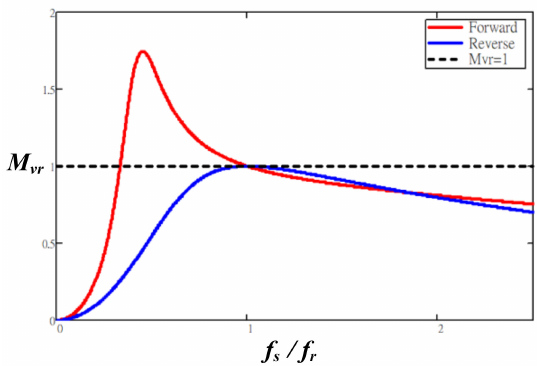
Figure 2. Voltage gain of LLC resonant converter at forward and reverse modes.